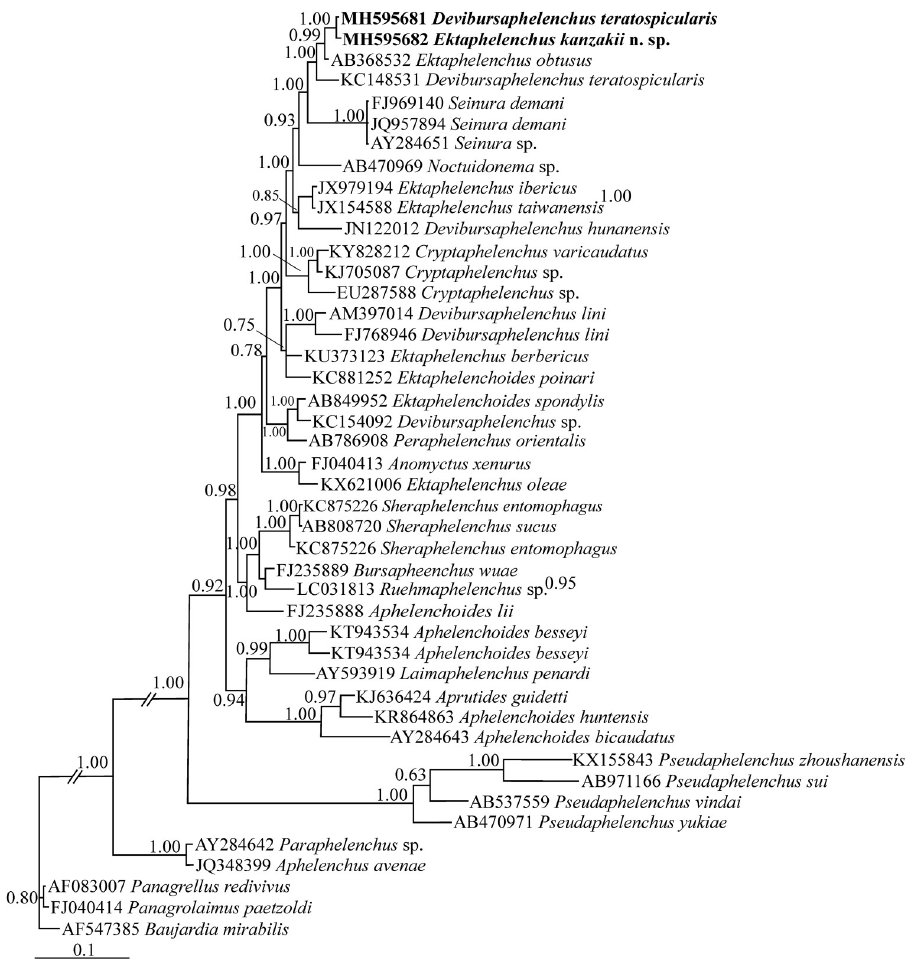
Fig 4. Bayesian 50% majority rule consensus tree inferred from SSU rDNA of Ektaphelenchus kanzakii n. sp. and Iranian population of Devibursaphelenchus teratospicularis Kakulia & Devdariani, 1965 [13] under the GTR + G + I model. Bayesian posterior probabilities (BPP) more than 50% are given for appropriate clades. New sequences are in bold font.